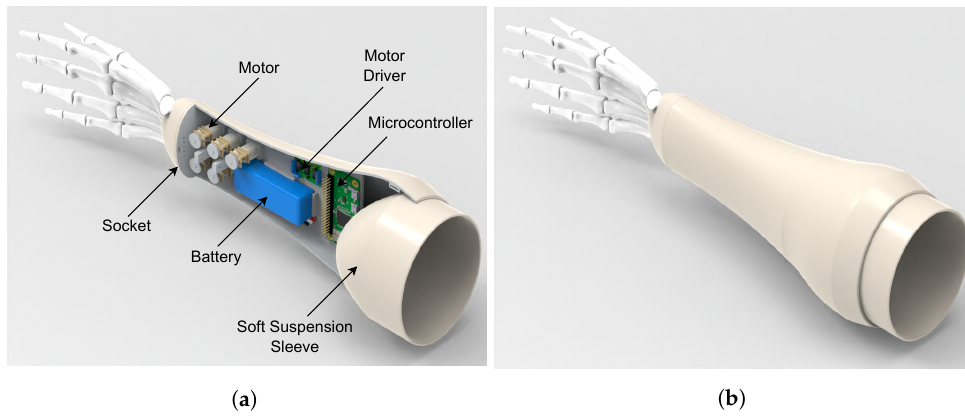
Figure 5. Soft prosthesis socket design. ( a ) Socket components. ( b ) Closed